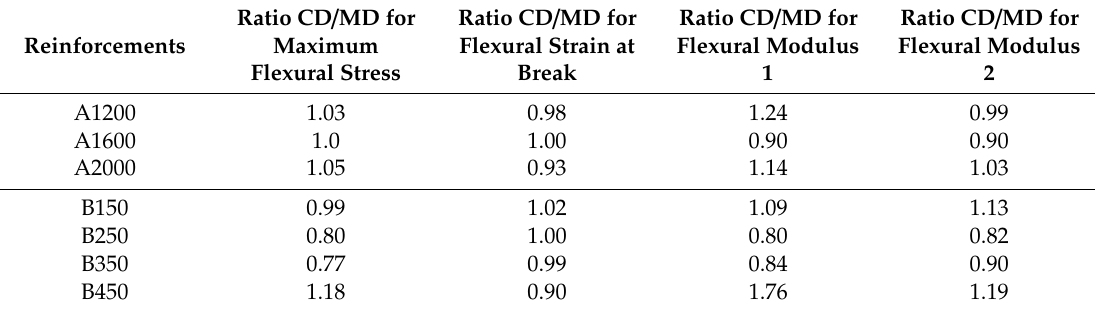
Table 4. Ratios of flexural anisotropy of nonwoven